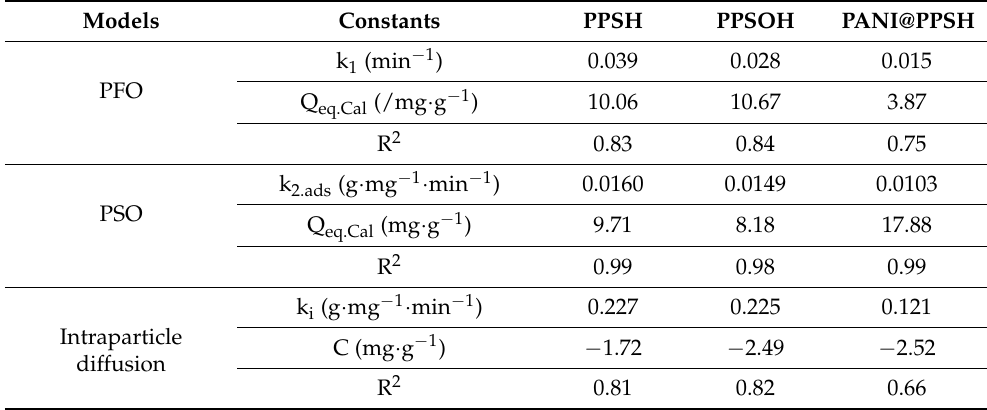
Table 2. PFO, PSO, and intraparticle diffusion sorption rate constants and Qeq value for the elimina- tion of CR on adsorbent samples at 298 K, pH: 6.5, and C 0 : 20 mg · L − 1 .